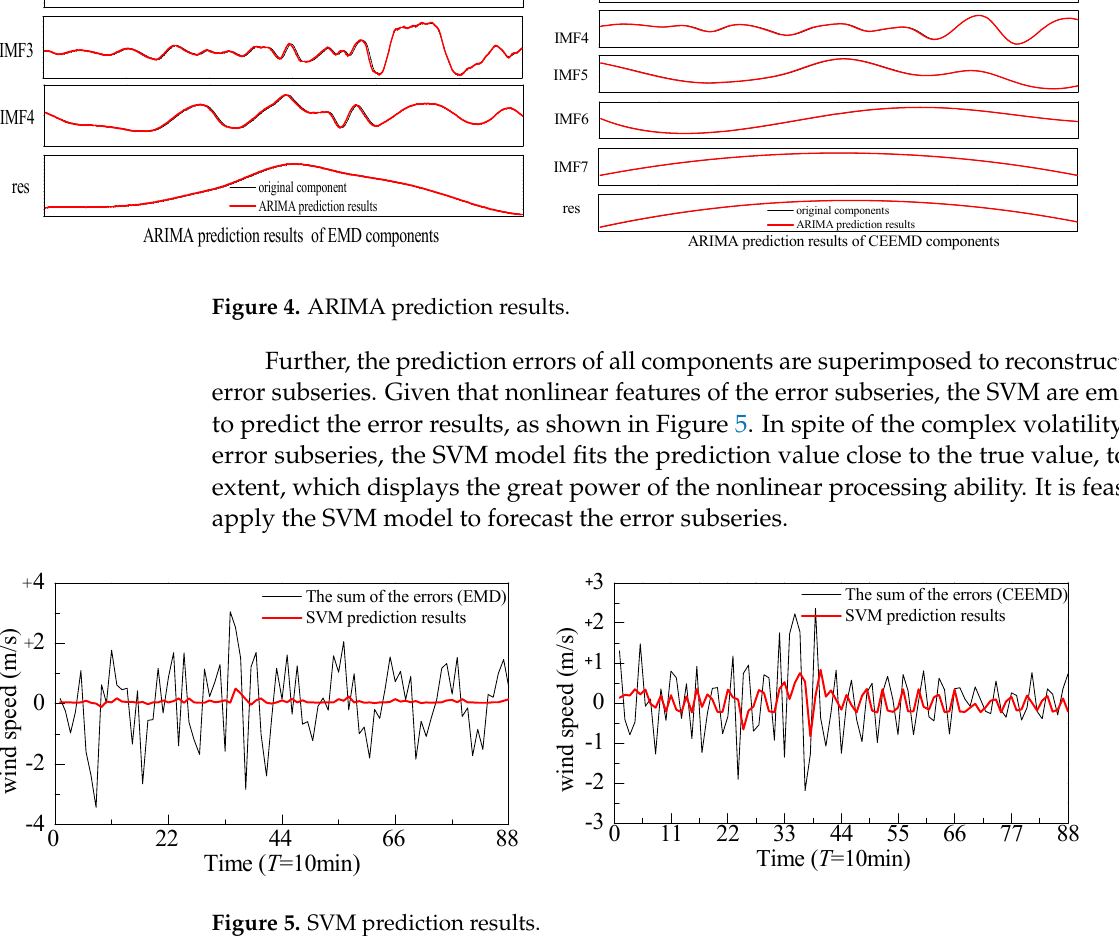
Figure 5. SVM prediction results.